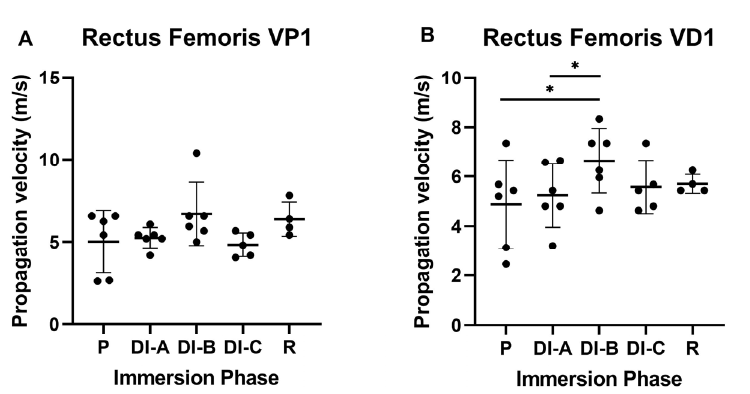
Figure 9. Propagation velocity for rectus femoris muscle (RF): ( A ) close proximal propagation (P1) and ( B ) close distal propagation (D1). The statistical significance of results is noted with an asterisk (*): * p < 0.05.